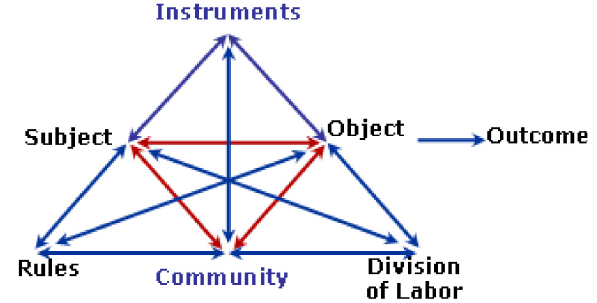
Figure 1. The human activity system representation in the Engestro¨m ’s perspective (adapted from [23]).